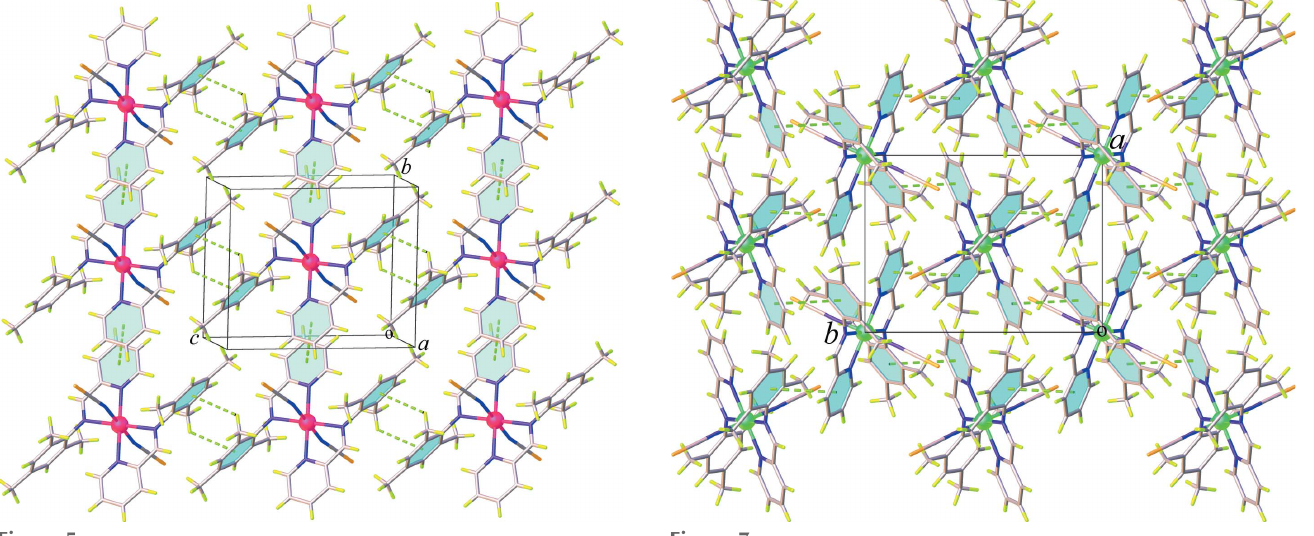
Figure 5 View of the three-dimensional network in ( I ) generated through C— H (cid:4)(cid:4)(cid:4) (cid:2) and (cid:2) – (cid:2) interactions.